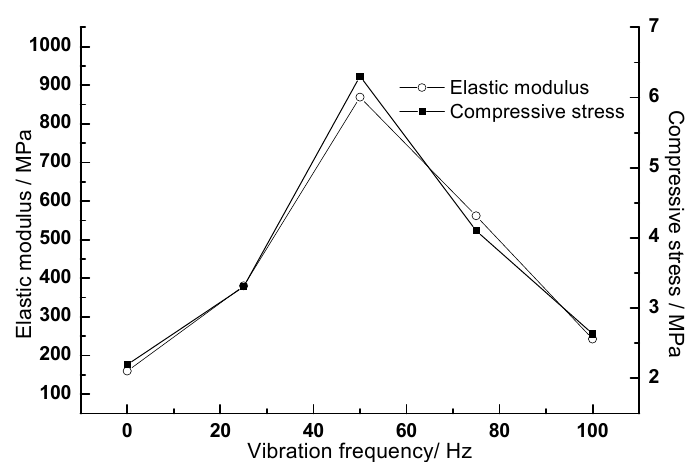
Figure 10. Effect of the vibration frequency on the properties of the CA mortar after the fatigue test.